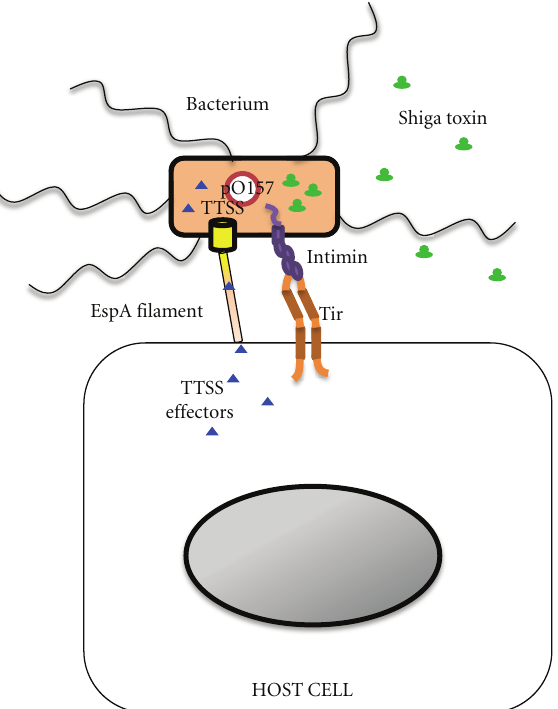
Figure 3: E. coli O157:H7 virulence factor expression and inter- action with host cells. E. coli O157:H7 possesses a large plasmid (pO157), carries the LEE PAI (and thus is intimin positive), and expresses Shiga toxins. The LEE locus encodes a TTSS and TTSS e ff ector proteins. One of the TSSS proteins, E. coli Secreted Protein (Esp) A, forms a filament that serves to translocate TTSS e ff ector proteins from the bacterium into the host cell by way of a pore created by EspB and EspD. One of these e ff ectors, Tir, serves as the receptor for the major adhesin, intimin, and thus allows adherence of the bacterium to the host